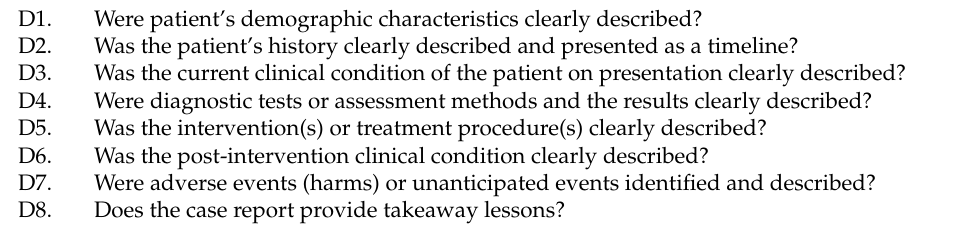
Table A1. JBI Critical Appraisal Checklist for Case